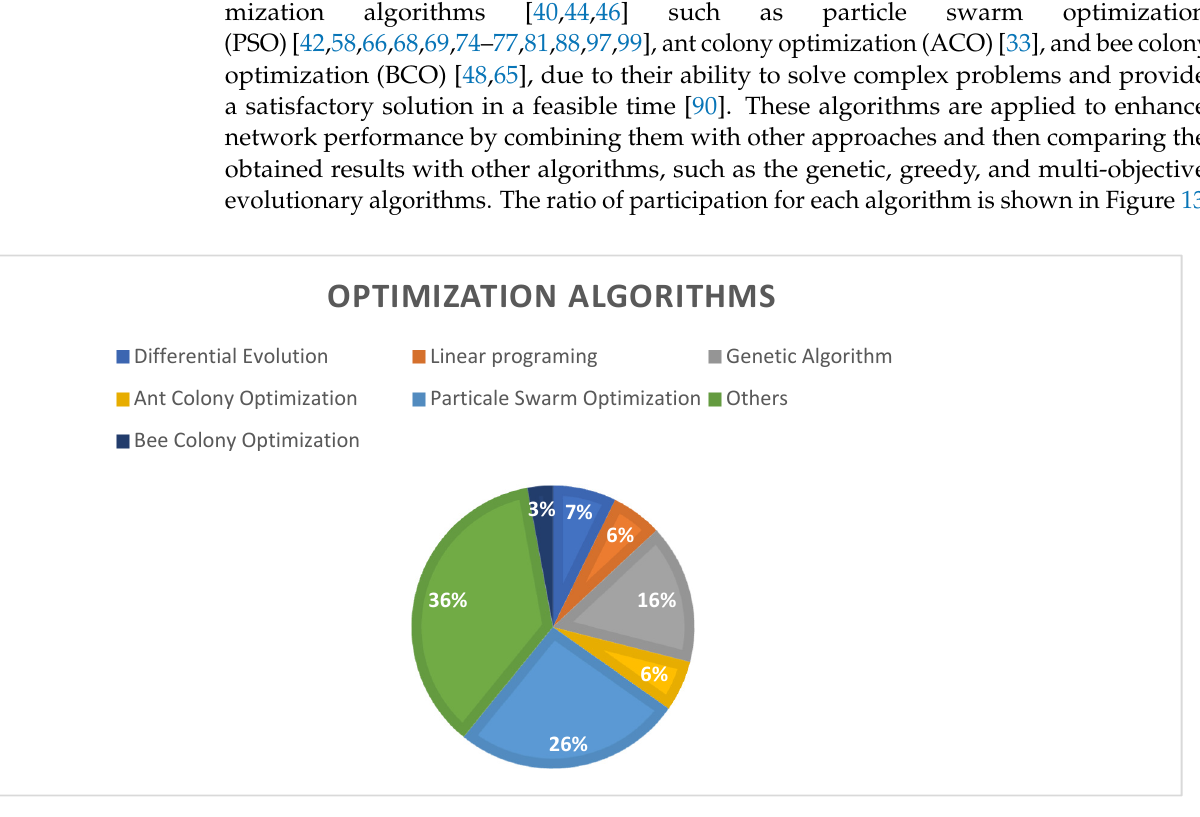
24 of 31 Figure 12. Papers ratio for each database. 5.2. Optimization Algorithms (RQ2 &RQ3) Most of the reviewed studies used meta-heuristic optimization algorithms to solve the deployment problem. The meta-heuristic stands for the Greek words meta and heuriskein , which means solving problems using an upper-level methodology. Meta- heuristic algorithms represent a part of optimization in computer science and applied mathematics concerning algorithms and computational complexity theory, which depend